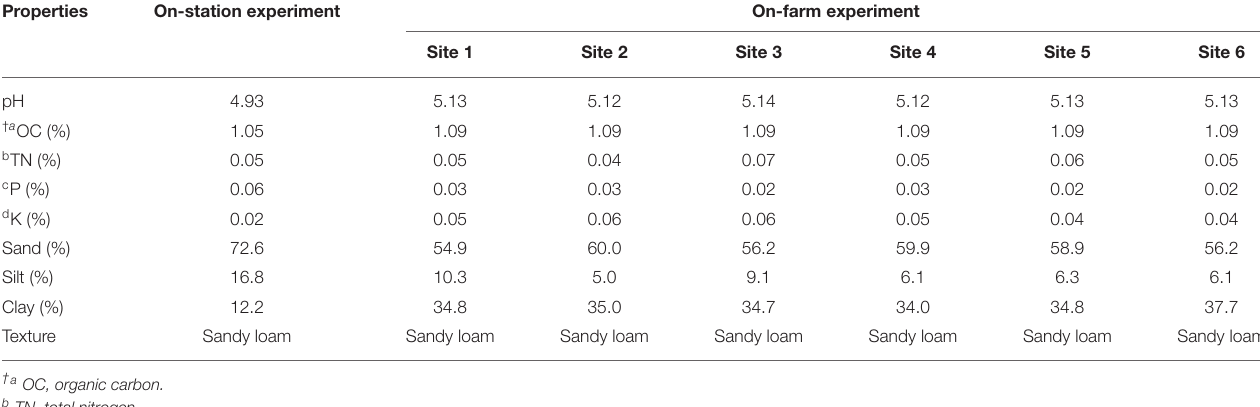
TABLE 1 | Chemical and physical properties of soil at the experimental sites. Properties